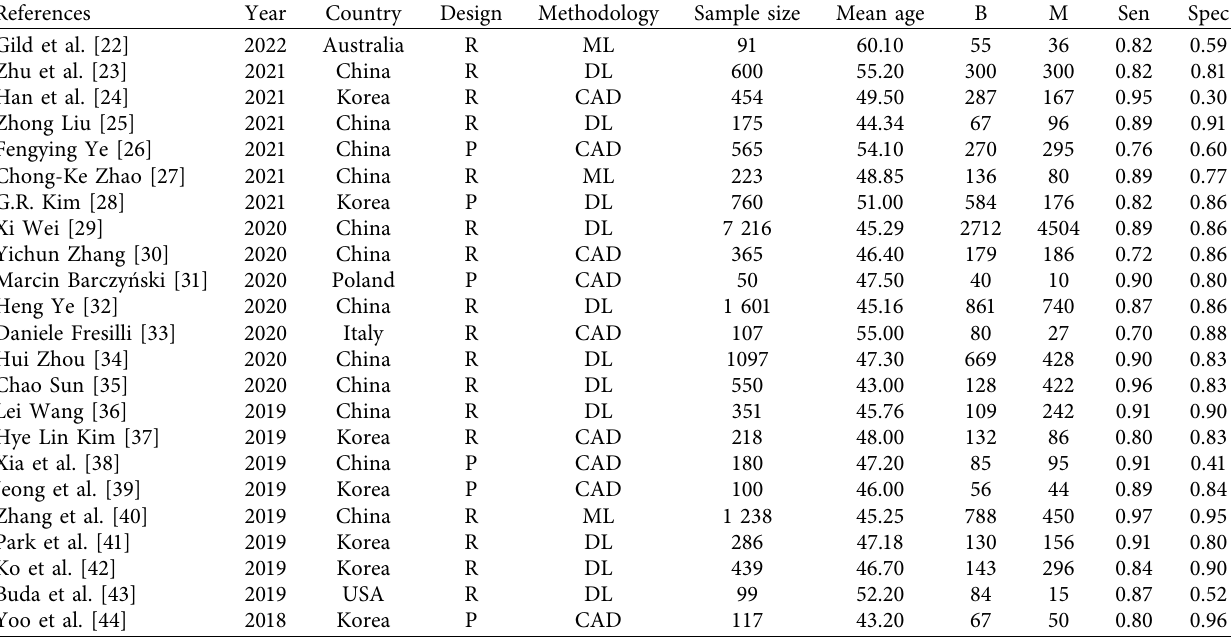
Table 1: Basic characteristics of included studies.